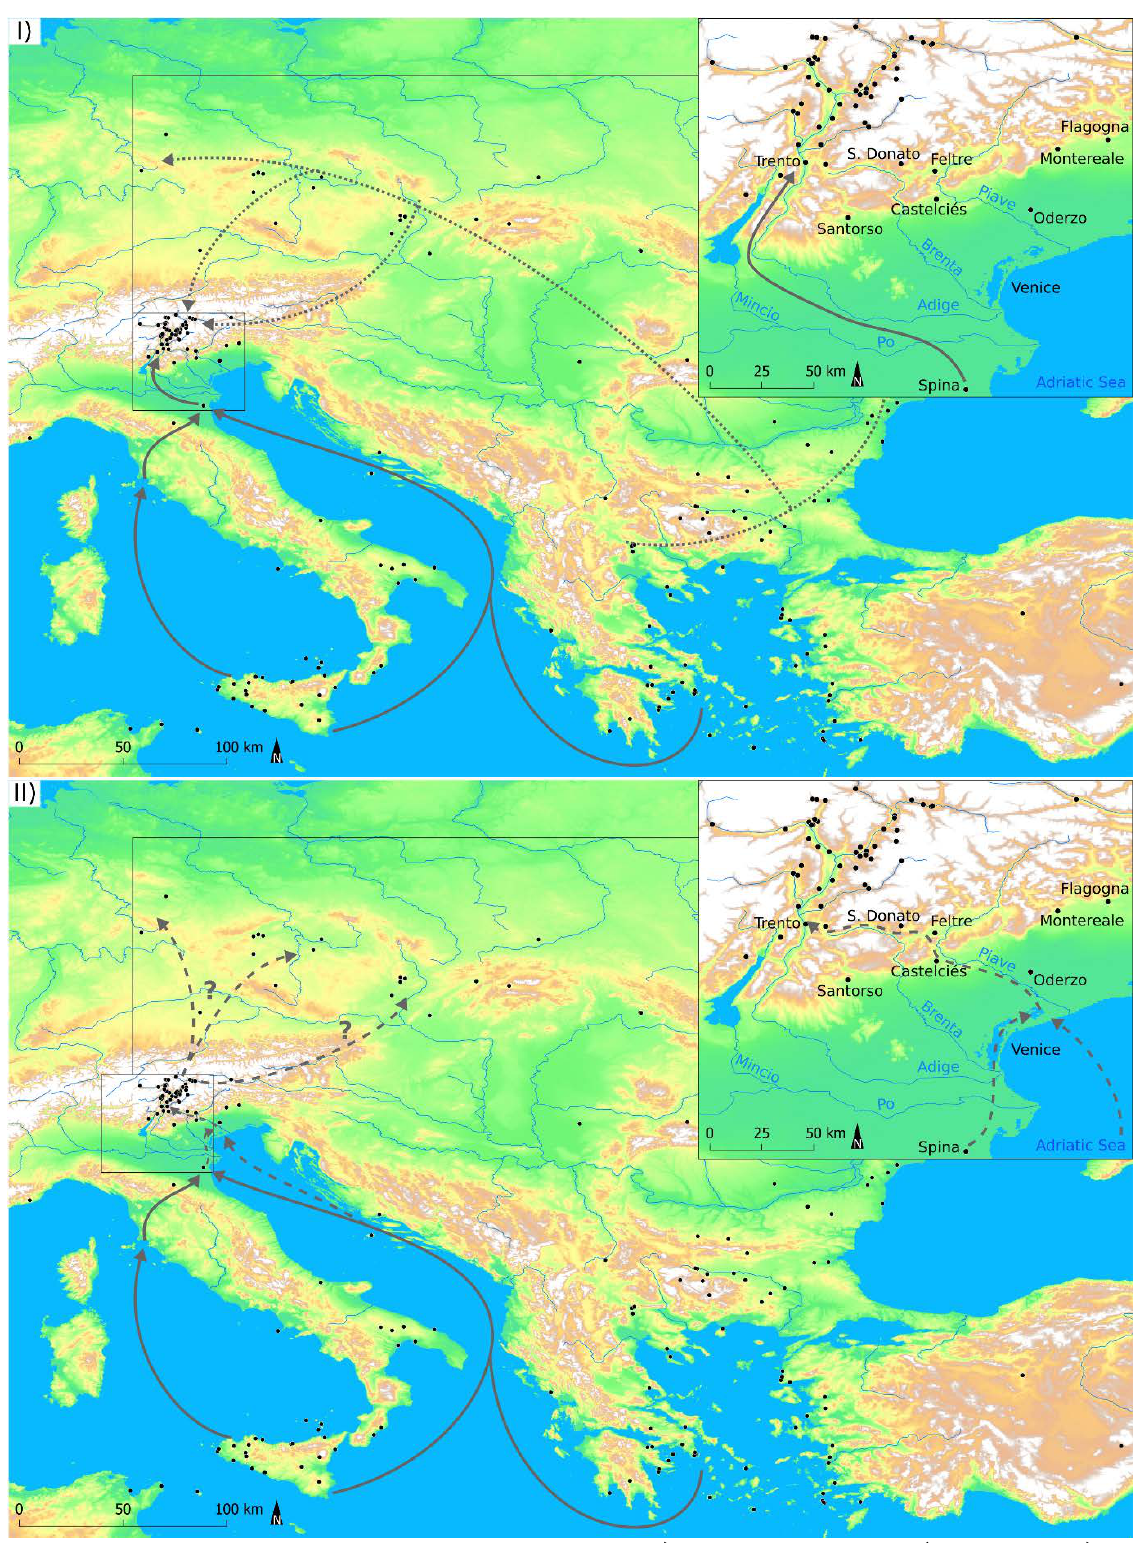
Figure 9. Olynthus mill in the Alps: old and new hypotheses. I) “Greek-Etruscan” way (continuous line) and “Balkan or Danubian” way (dotted line); II) Venetian “Piave-Brenta” way (dashed